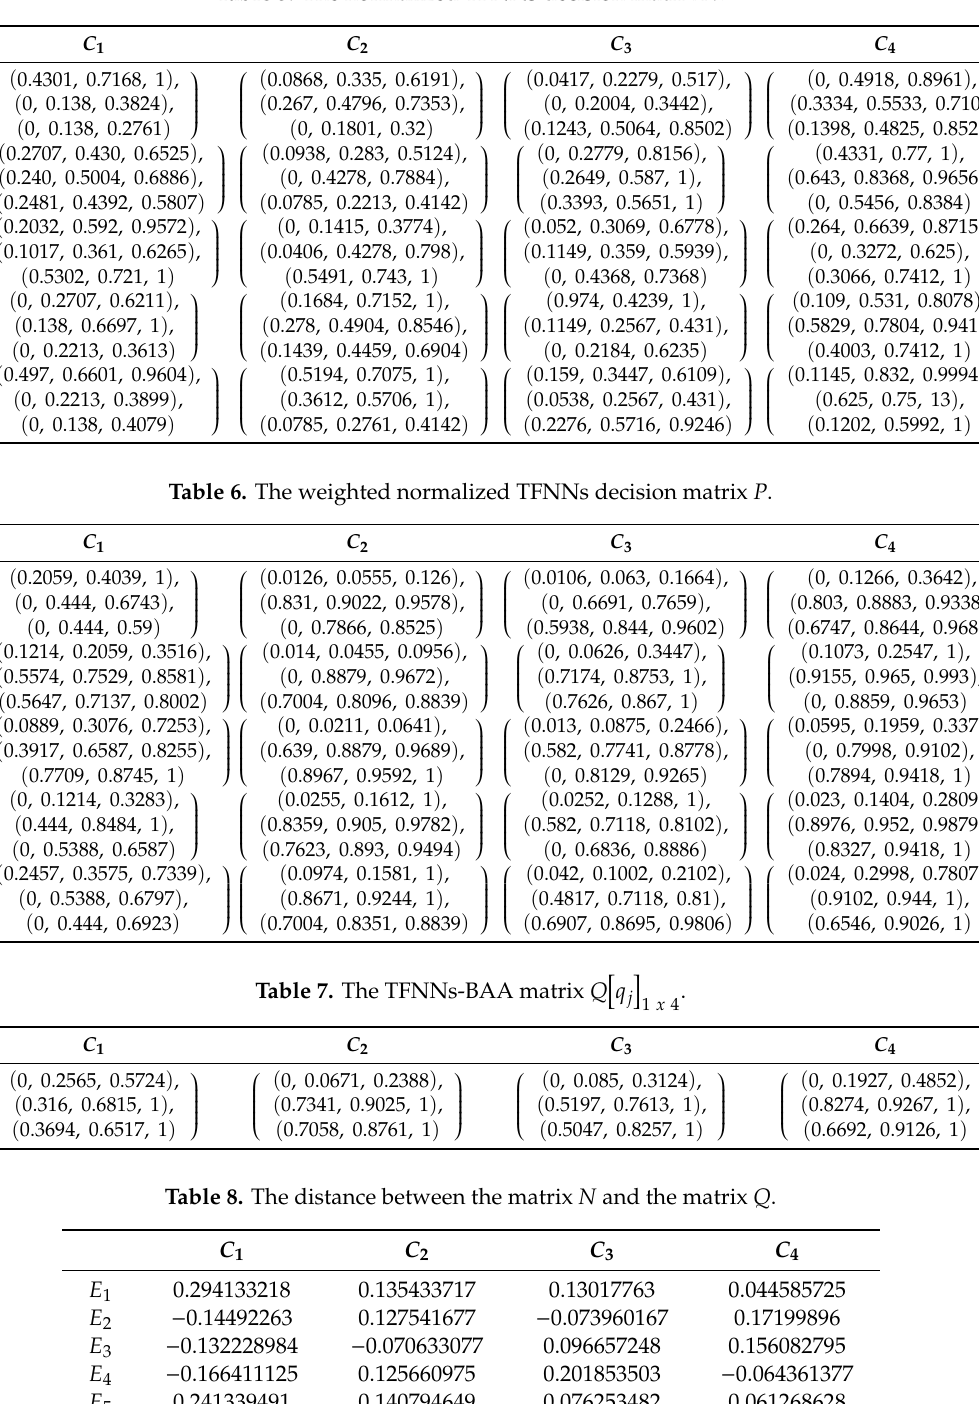
Table 5. The normalized TFNNs decision matrix N .